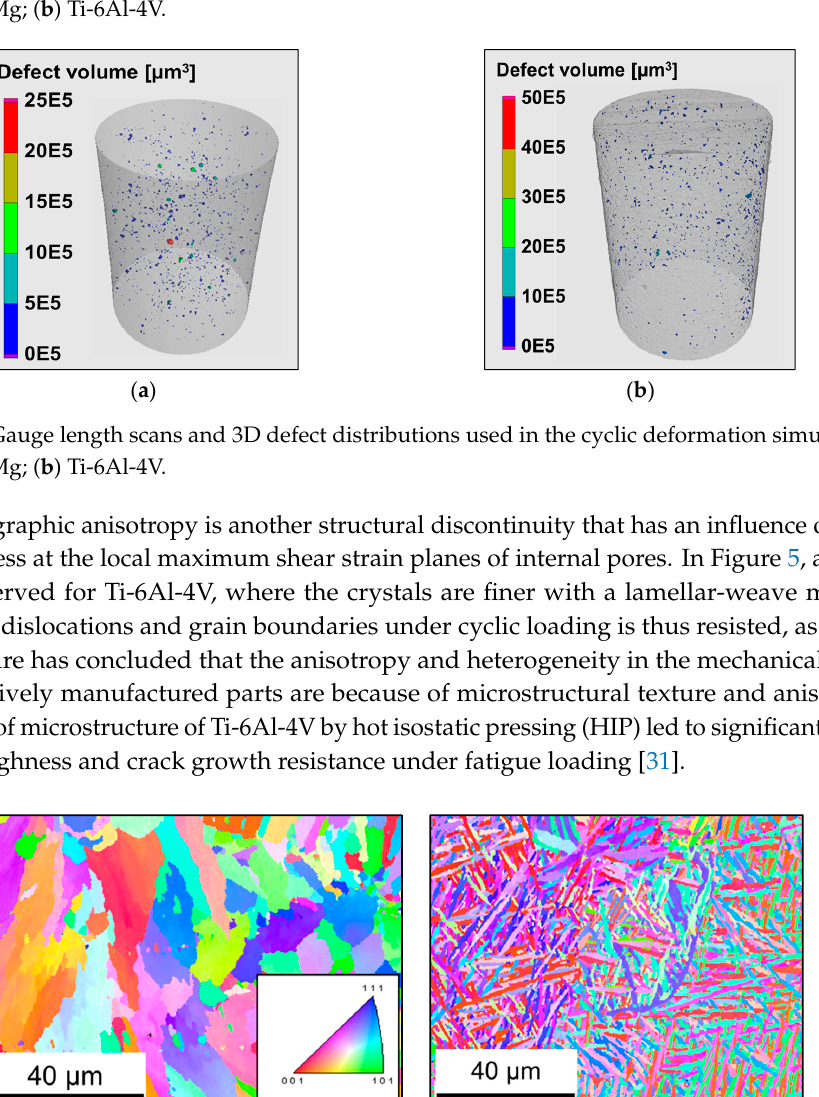
Figure 3. Cyclic stress–plastic strain amplitude curves used to deduce kinematic hardening parameters: ( a ) AlSi10Mg; ( b ) Ti-6Al-4V.